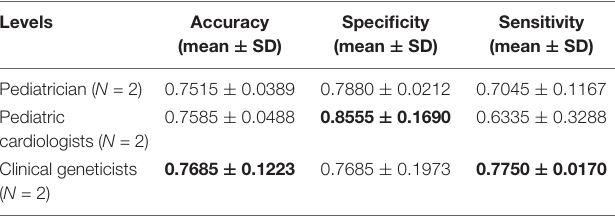
Values in bold indicate the optimal performance. SD, standard deviation.